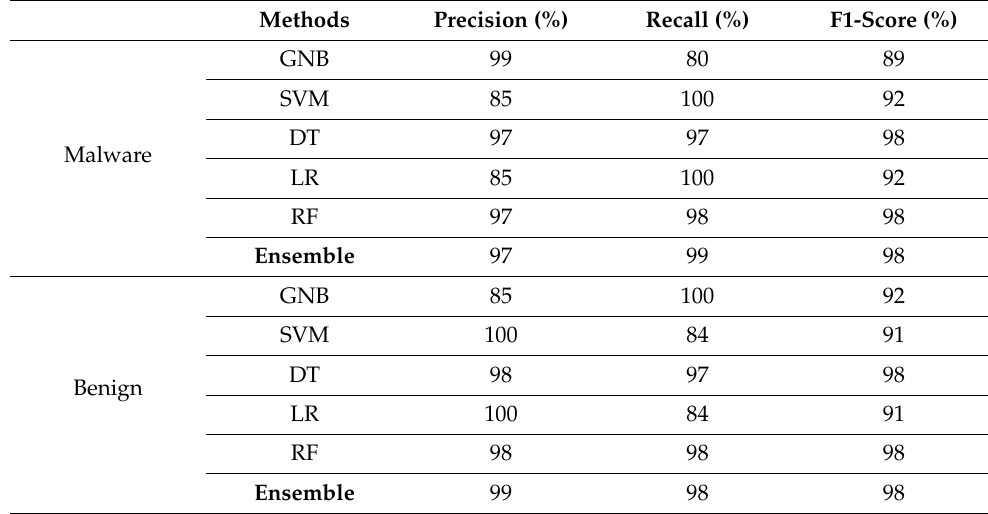
Table 4. Performance measures for malware detection using dataset